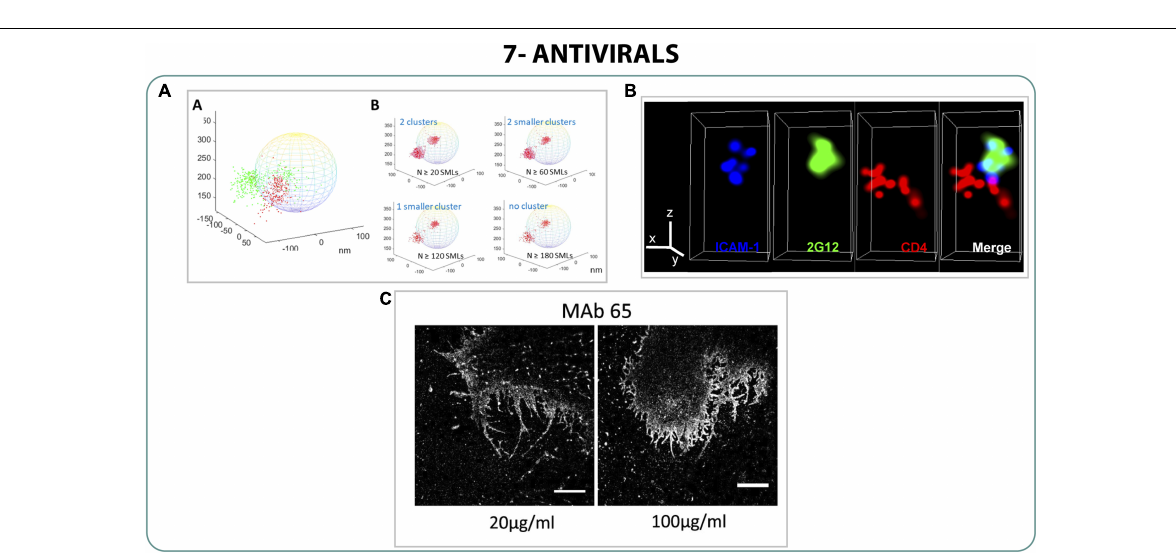
FIGURE 8 | Antivirals. (A) 3D iPALM imaging of Env (red) and SER5 (Green) projected onto a 200 nm diameter model sphere representing a viral particle (Chen et al., 2020). (B) STORM images of the monoclonal antibody 2G12 (green) with the virion (blue) and CD4 receptor (red) (Mengistu et al., 2015). (C) STORM images of filaments of influenza treated with two different concentrations of a monoclonal antibody MAb 65. Scale bar 5 µ m (Kolpe et al.,